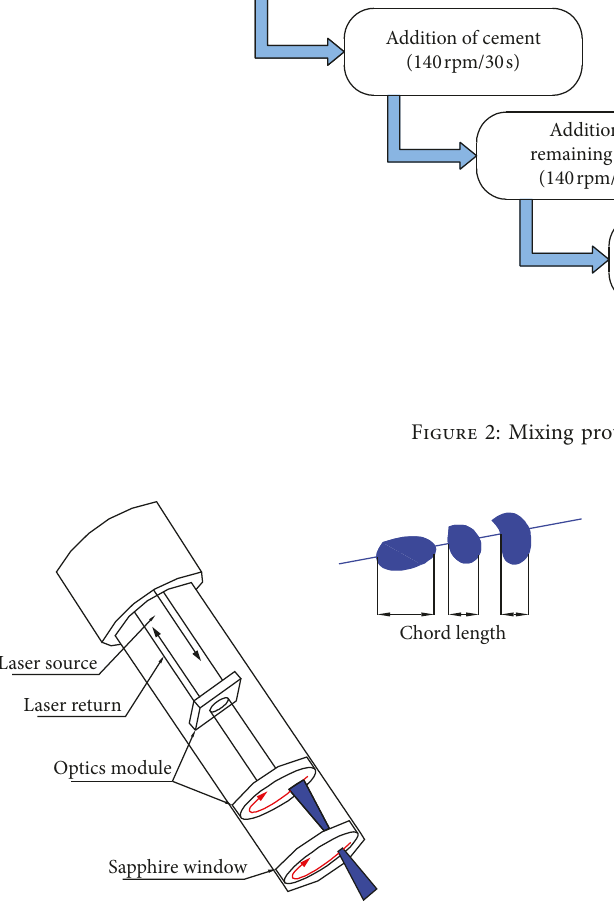
Figure 3: FBRM probe operation